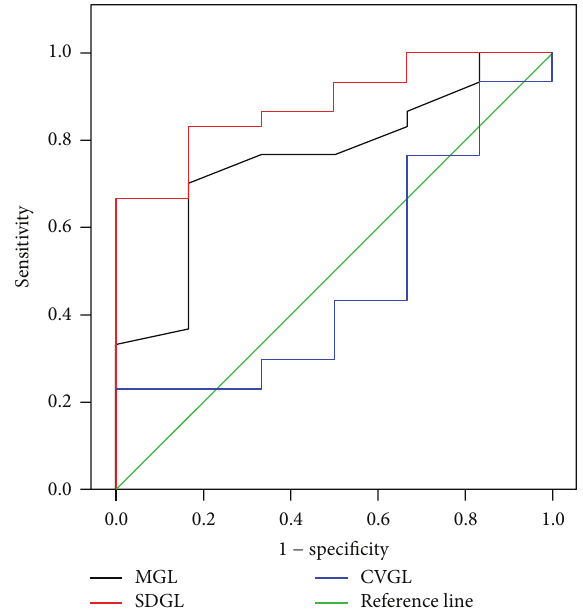
Figure 2: ROC curve for the three parameters considered (mean (MGL), standard deviation (SDGL), and coefficient of variation of gray level (CVGL)) when comparing flat bone groups (multiple myeloma MM2 versus osteolytic metastases